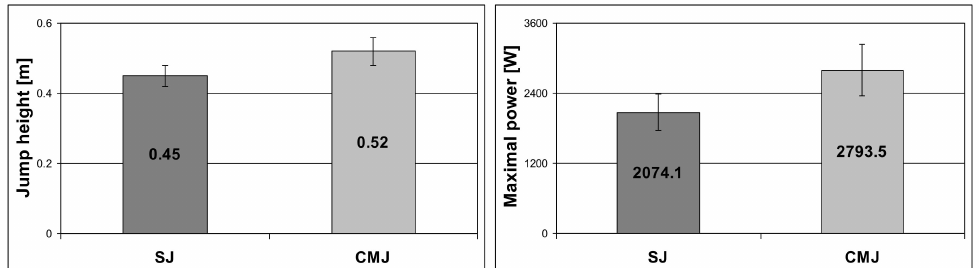
Figure 3. Results of the jump height and maximal power during the SJ and CMJ.